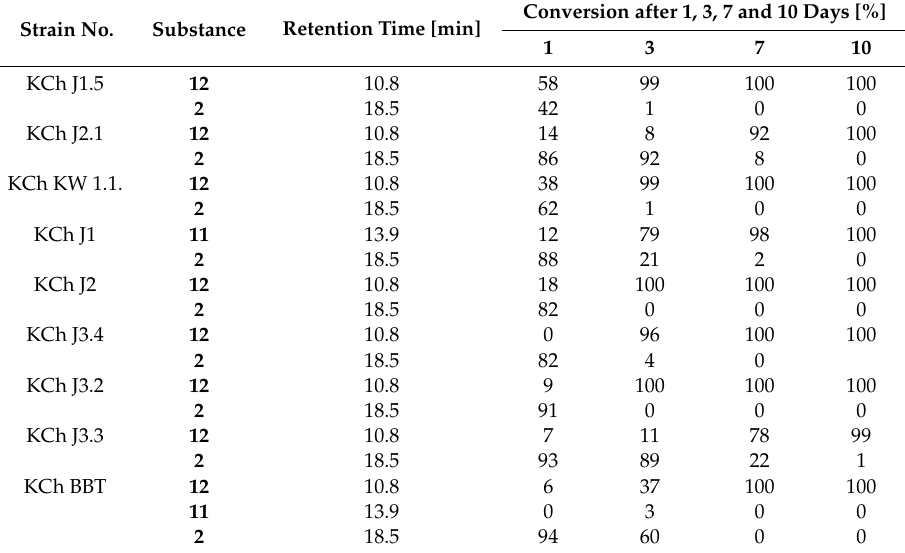
Table 3. Microbial transformation of 3 (cid:48) -methoxyflavone, HPLC conversion. Strain No.